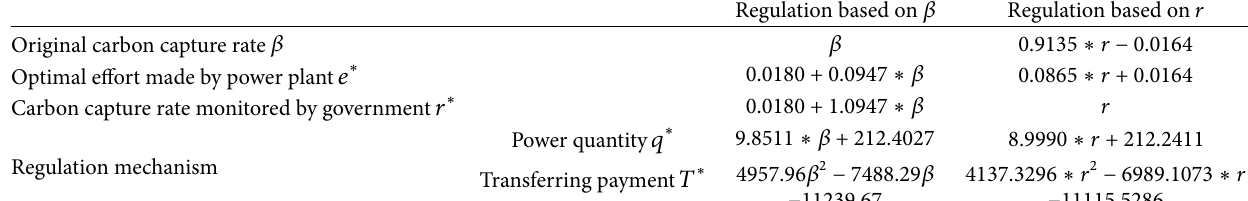
Table 2: Regulation mechanism and its effect.